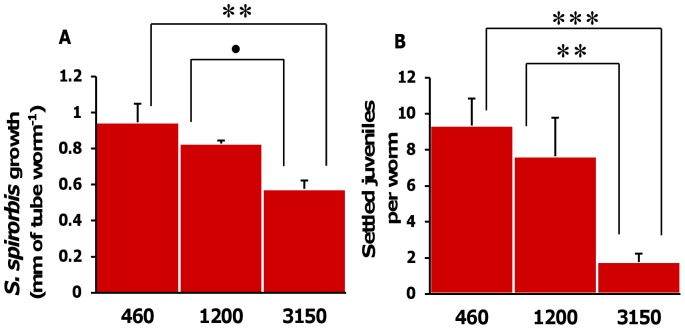
Growth and reproduction of S. spirorbis.(A) Growth of the tubes of S. spirorbis during the 30 days of incubations at 460 µatm, 1200 µatm and 3150 µatm pCO2, data are the mean ± SE of newly formed tubes sections in mm per worm per flask. (B) Settlement of S. spirorbis during the 30 days of incubations at 460 µatm, 1200 µatm and 3150 µatm pCO2, data are the mean ± SE of the number of juveniles settled per adult between flasks. One-way ANOVAs, n = 10, statistical significance: ***: p≤0.001, **: p≤0.01, *: p≤0.05, •: p<0.1.